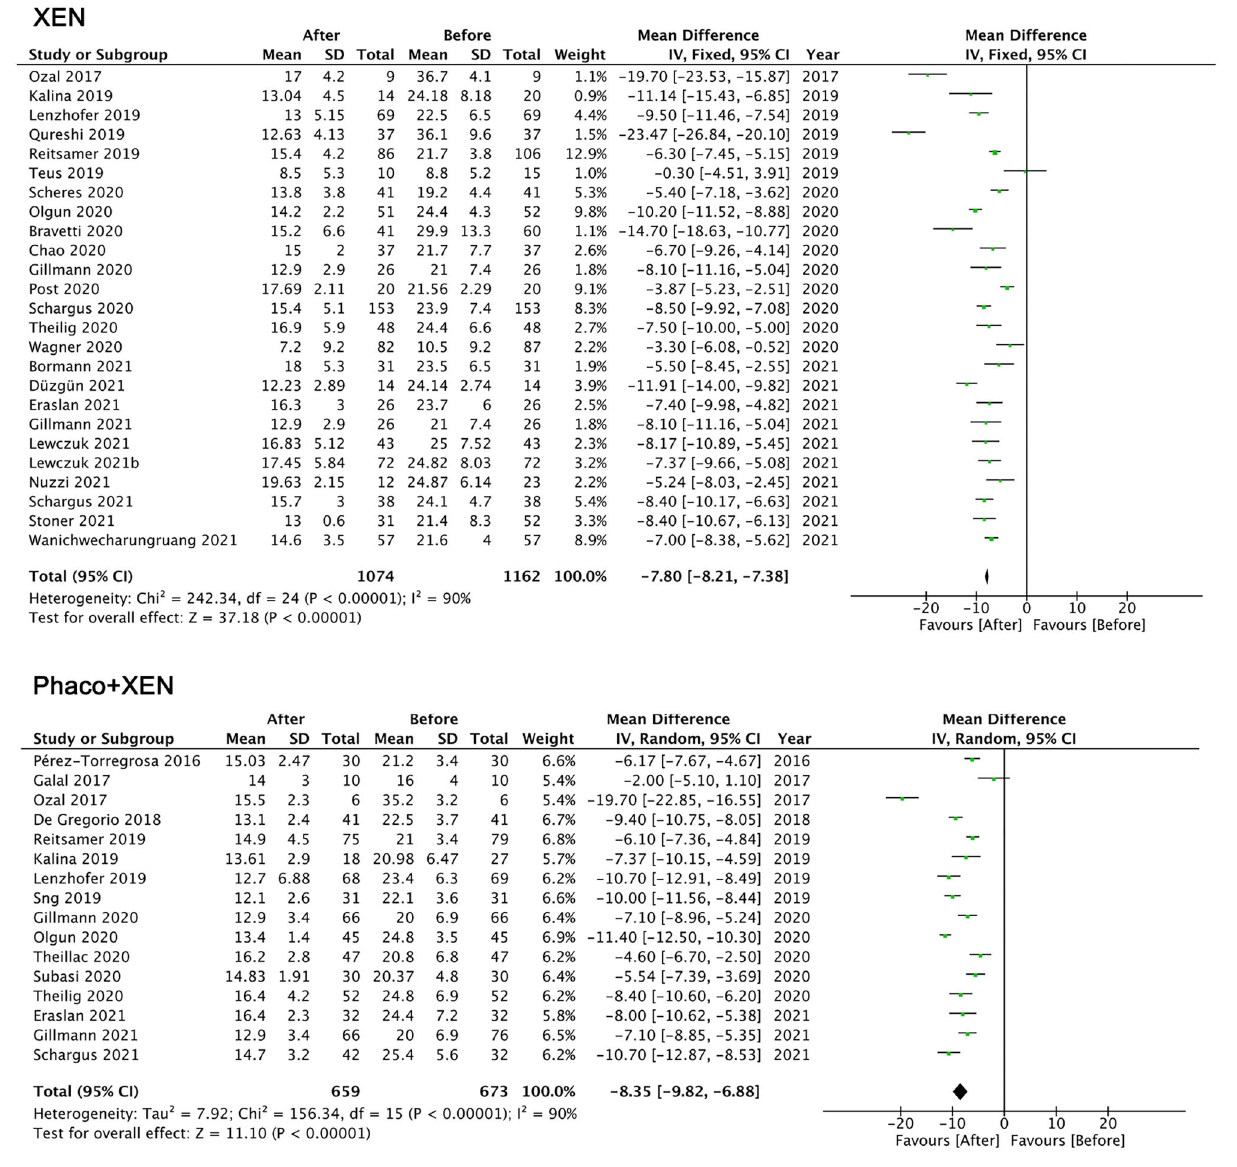
treated with argon laser iridoplasty (55) or a second XEN